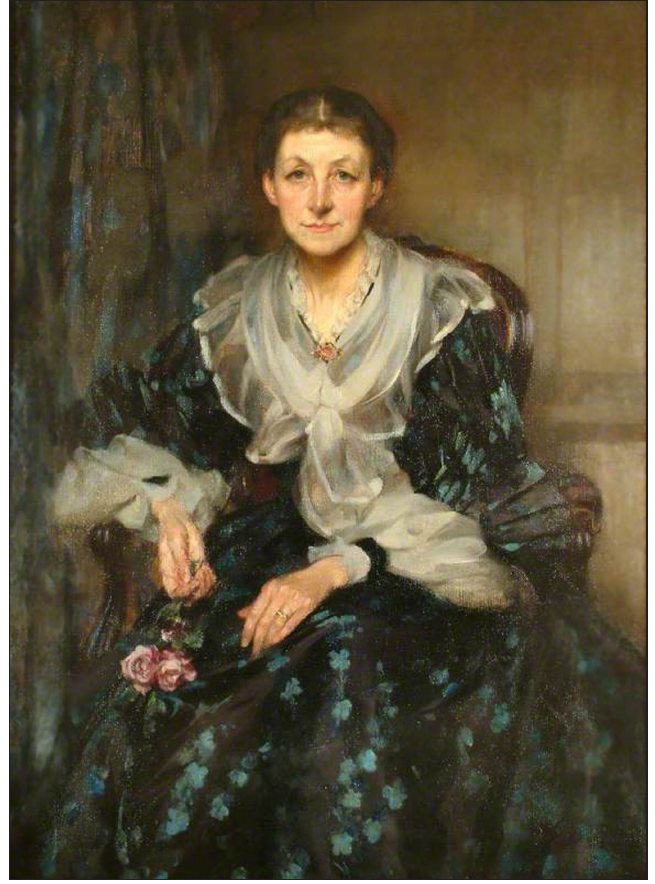
Fig. 5 : James Jebusa Shannon, Miss Matilda Ellen Bishop , 1897, oil on canvas, 125.7 × 101.6 cm, Royal Holloway, University of London,